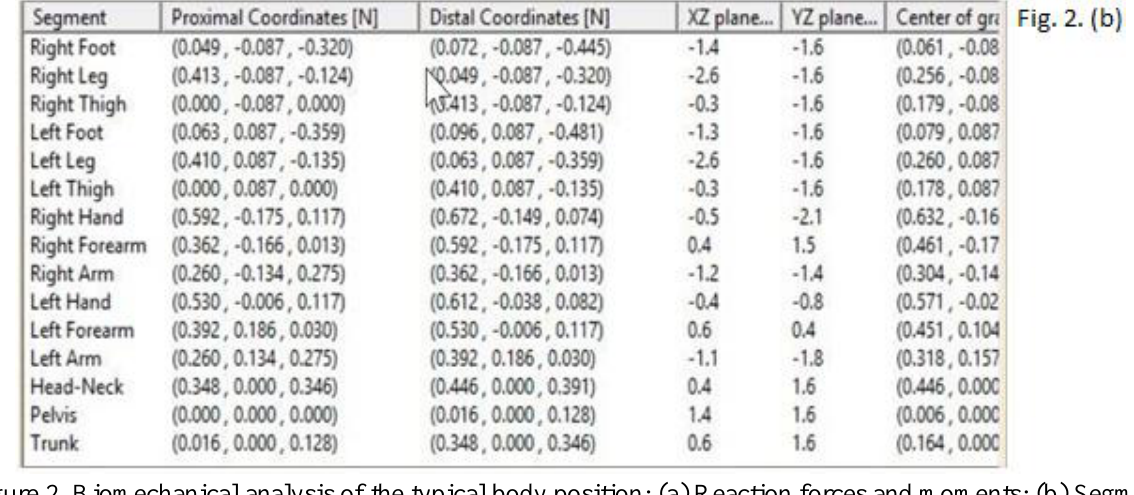
Figure 2. Biomechanical analysis of the typical body position: (a) Reaction forces and moments; (b) Segment positions